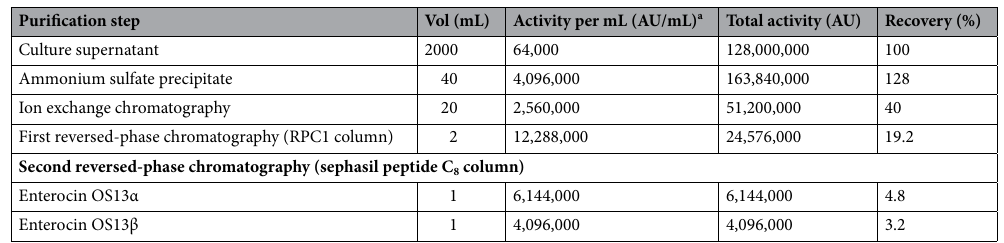
Figure 1. Phylogenetic tree of bacteriocinogenic isolates based on partial 16S rDNA gene sequences. The percentage of replicate trees in which the associated taxa clustered together in the bootstrap test (1000 replicates) are shown next to the branches.